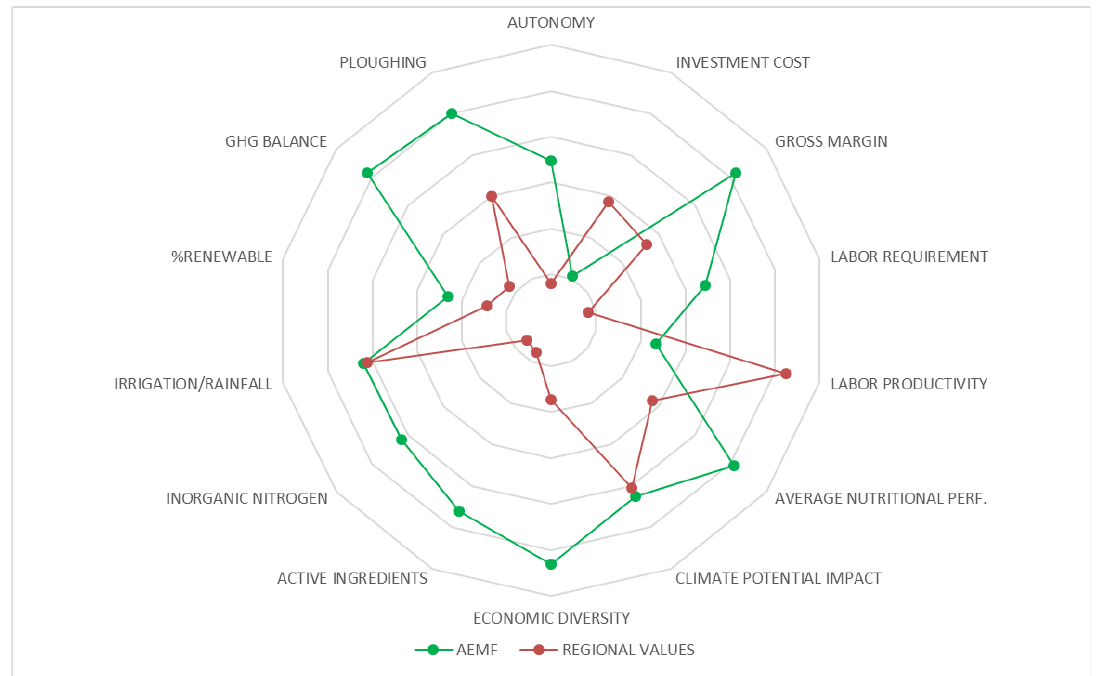
Figure 4. Synthetic view of the relative scores of the indicators for both the AEMF and the average regional farming system. Note: after mean-centering the scores, we multiplied the values of indicators that should have decreased (Investment cost, Climate potential impact, Active ingredients, Inorganic nitrogen, Irrigation/rainfall, GHG Balance, and Ploughing) by − 1 in order to have the same reading. Higher values correspond to better